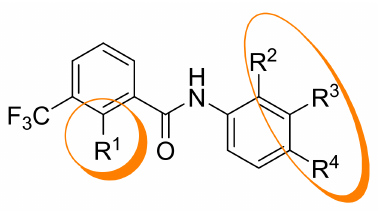
Figure 8. Positions of structural modifications. Table 4. Summary of SAR of compounds against P. falciparum NF54 expressed as IC 50 ( µ